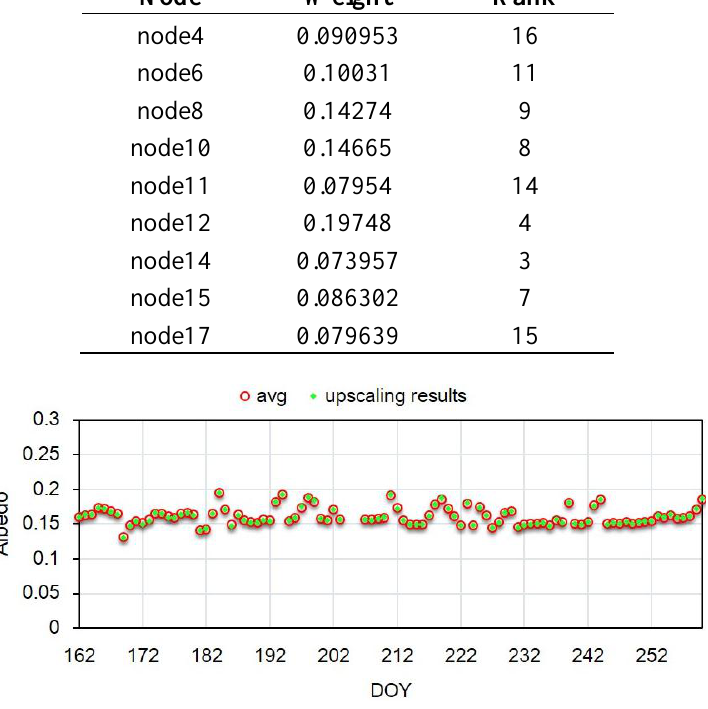
Figure 12. Comparison between daily time series of the average value based on all measurement nodes and the upscaling results in the field